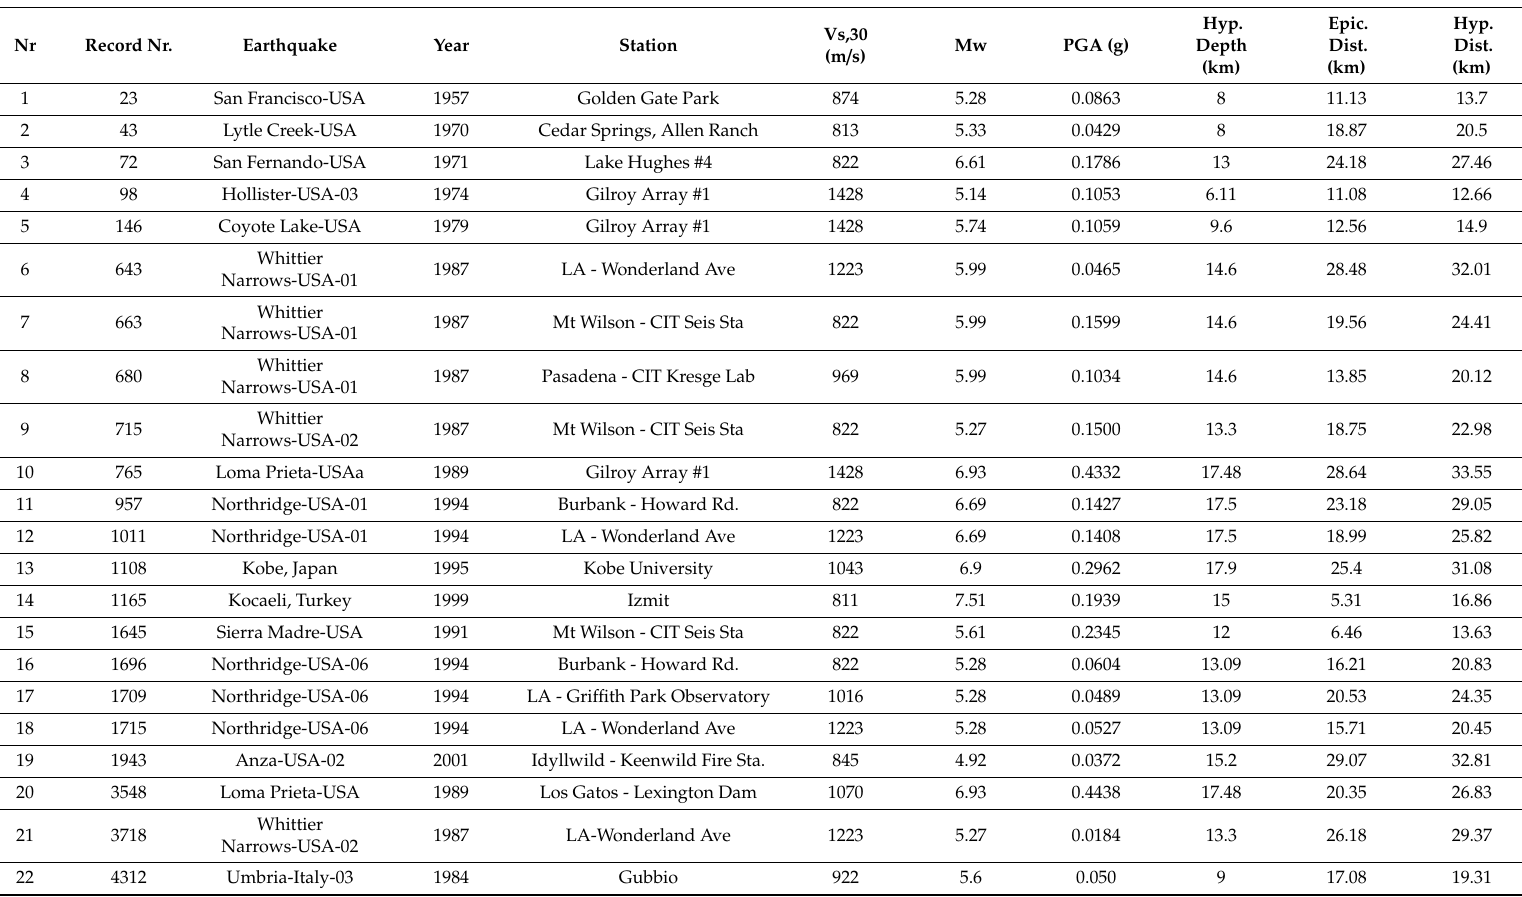
Table 1. Ground motions (horizontal components) from PEER database used in 1-D EQL site response analysis. Source: (http: // ngawest2.berkeley.edu / ). Nr Record